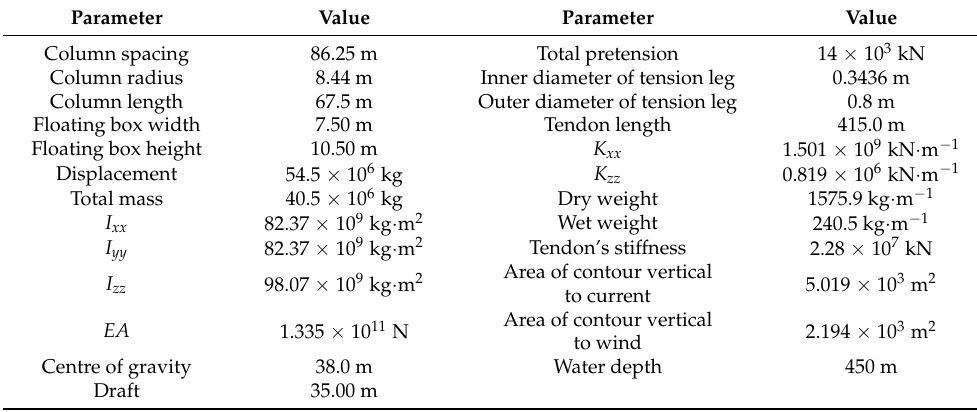
Table 2. Main parameters of the ISSC TLP [50].